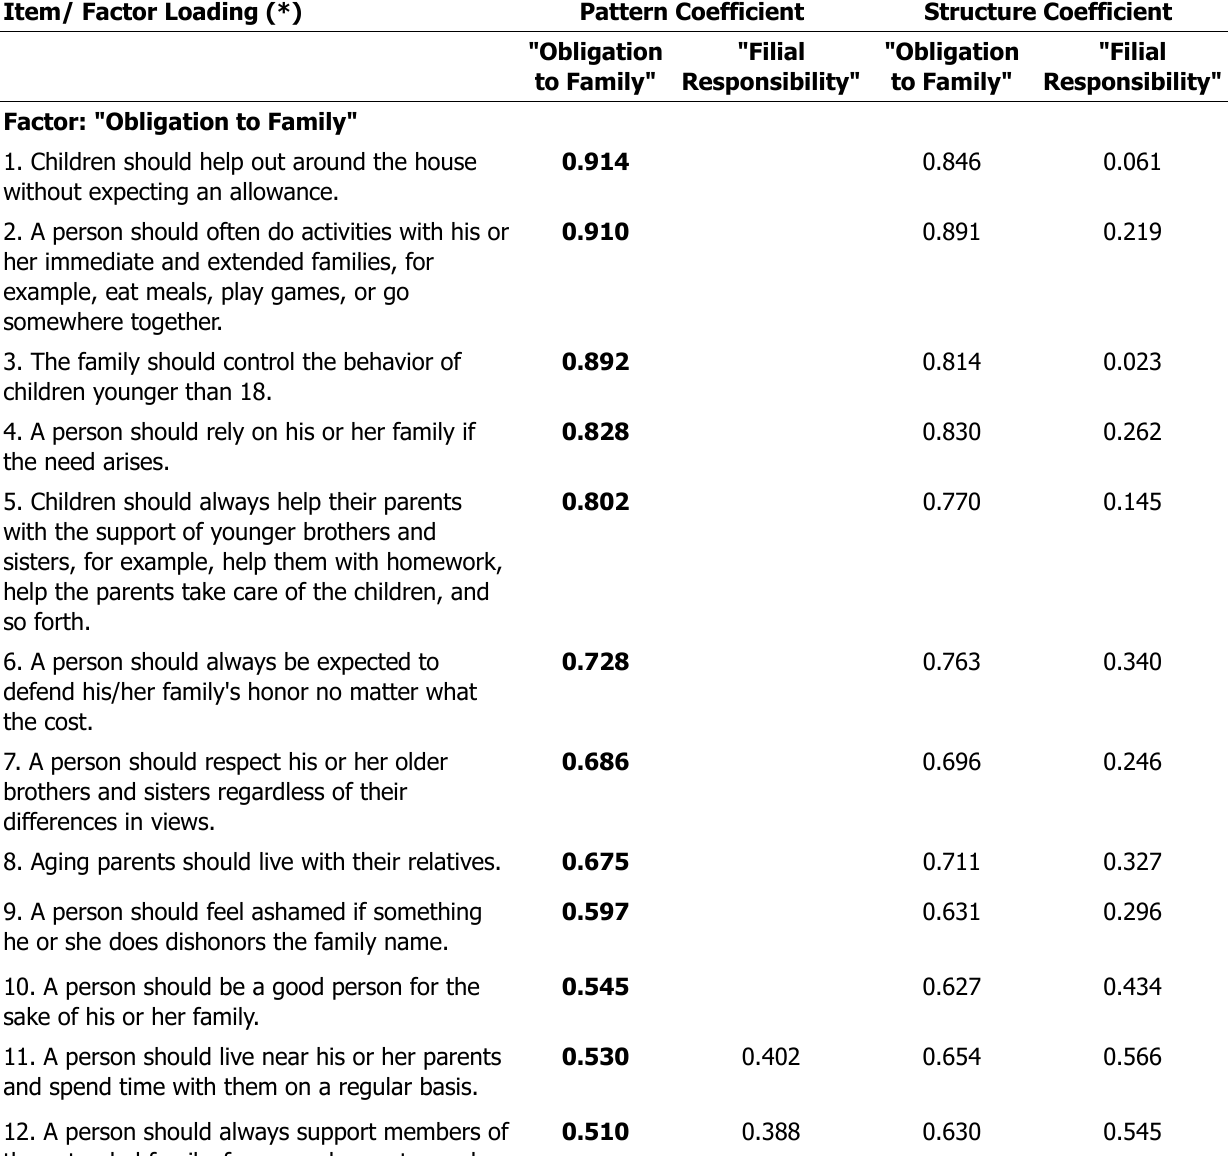
Table 1. Pattern and structure matrix for the LSC AFS Familism